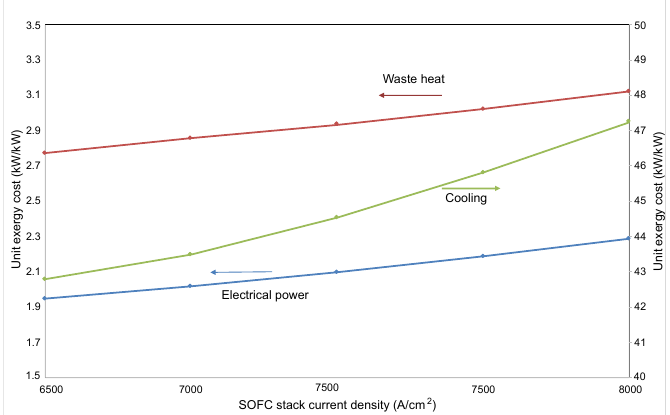
Figure 7. Variation of the unit exergy cost of electricity, exhaust gases and refrigeration as a function of the current